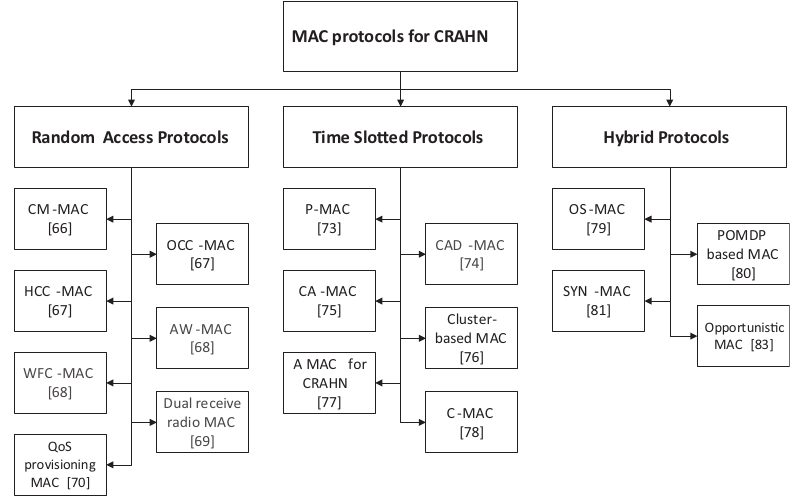
Figure 3. Classification of the MAC protocols